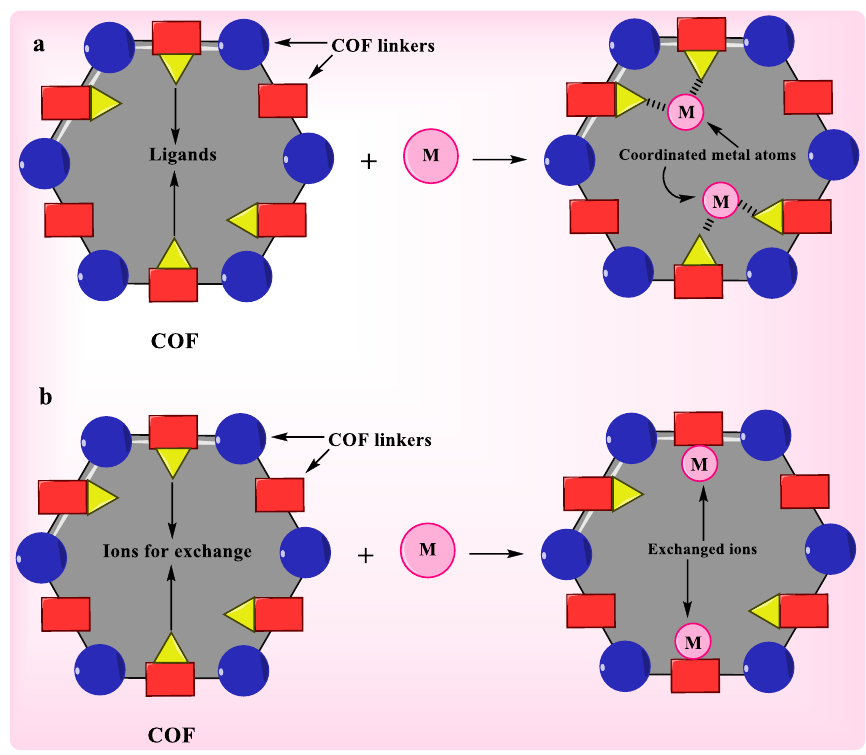
Figure 4. Coordinative adsorption ( a ) and ion-exchange method ( b ) [66] .